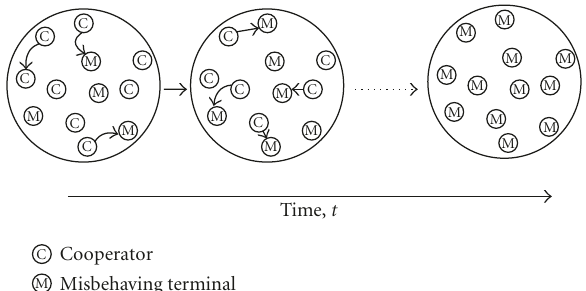
Figure 3: Evolution of misbehavior in cooperative diversity in the absence of a mechanism to mitigate e ff ects of deviation from the rules of cooperation.